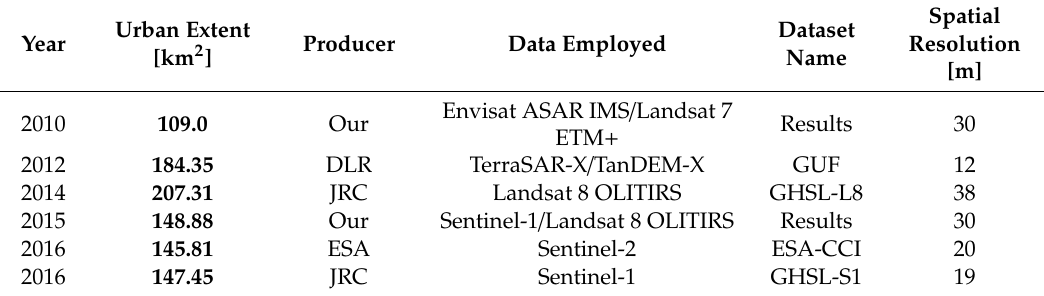
Table 7. Characteristics of the di ff erent urban layers and land cover maps employed and measured urban extent across the El-Minya governorate. The temporal evolution of the urban extent shows unrealistic urban extension over time, as urban extent only increased in our study area during that period.